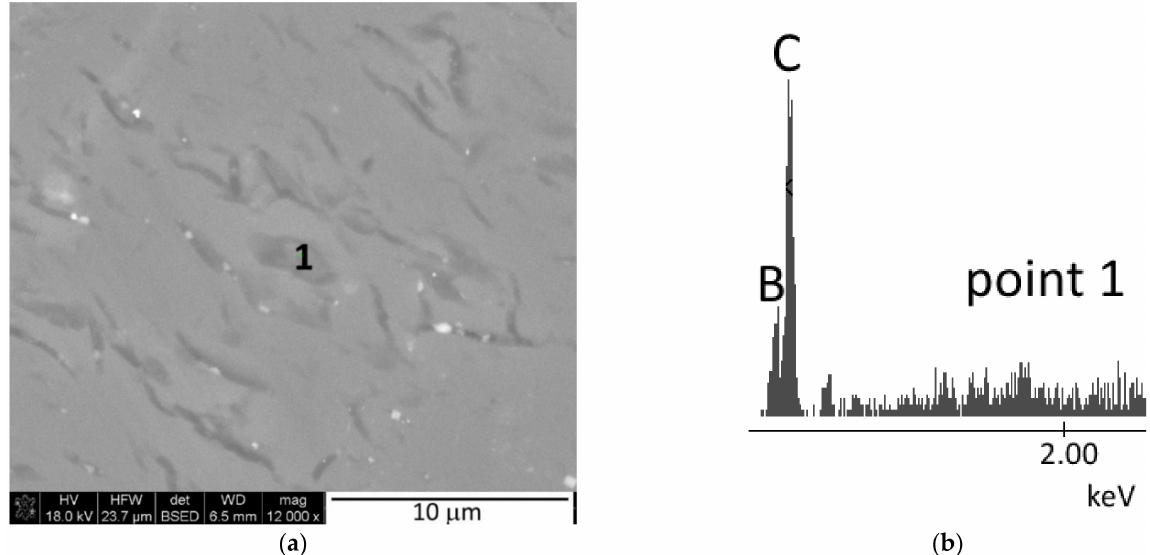
Figure 8. EDS analysis ( b ) of the micro-area marked as point 1 ( a ) of the sample obtained from a mixture with B:C = 15:1 ratio, sintered at 1900 ◦ C. In the following Figure 9, SEM microstructure images of polycrystals sintered at 1900 ◦ C, differing in the initial composition (i.e., B:C mass ratio) are summarized. It is observed that the larger the initial B:C mass ratio was, the higher the grains are in the sinter.